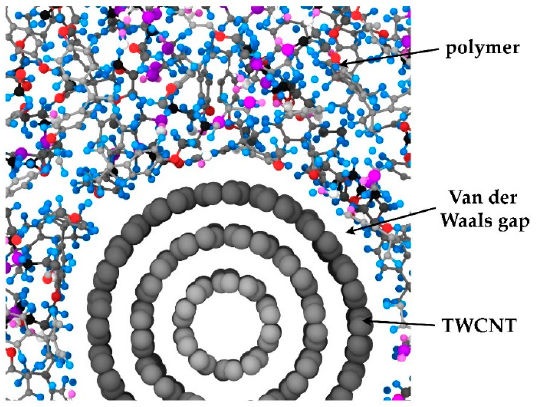
Figure 5. Detail of the interface region in TWCNT nanocomposite (obtained from Model